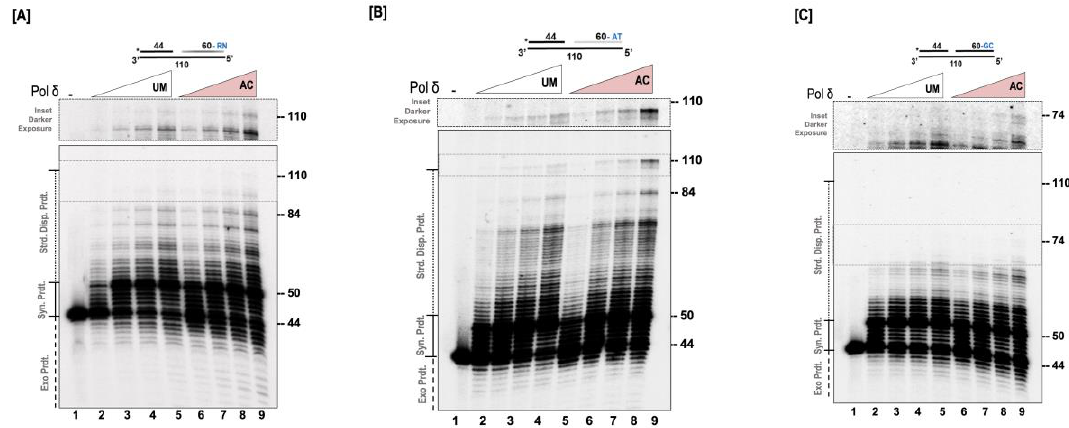
Figure 3. Acetylation stimulates the strand displacement activity of pol δ . The strand displacement activity of pol δ was assayed using the 5 nM substrate at varying concentrations of either unmodified or acetylated pol δ (20, 50, 100, and 200 nM) as described in the “Section 2.6”. ( A ) Substrate (U 1 :D 1 : T 1 ) contains a randomly (RN) generated downstream blocking sequence. ( B ) Substrate (U 1 :D 3 : T 3) contains an AT-rich downstream blocking (AT) sequence. ( C ) Substrate (U 1 :D 2 : T 2) contains a GC-rich downstream blocking (GC) sequence. The substrate is depicted above each gel image and the asterisk denotes the location of the radiolabel. Exonuclease products (Exo. Prdts.), synthesis products (Syn. Prdts.), and strand displacement products (Strd. Disp. Prdts.) are indicated adjacent to the gel image. Nucleotide sizes are also